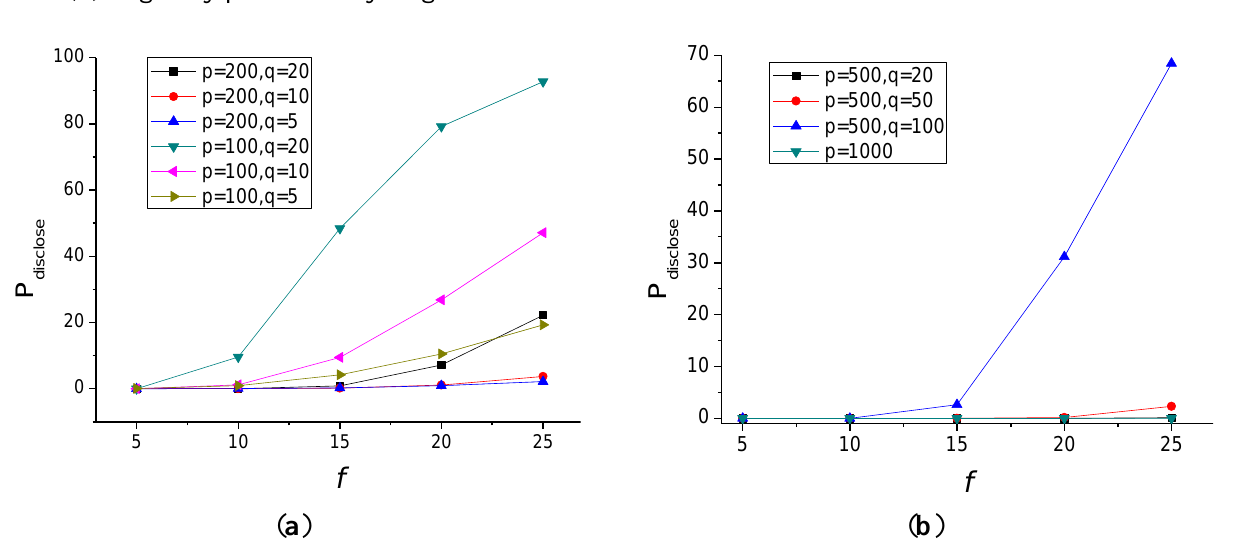
Figure 2. Theoretical value of P disclose in PDACAS with ( a ) small key pool and key ring and ( b ) large key pool and key